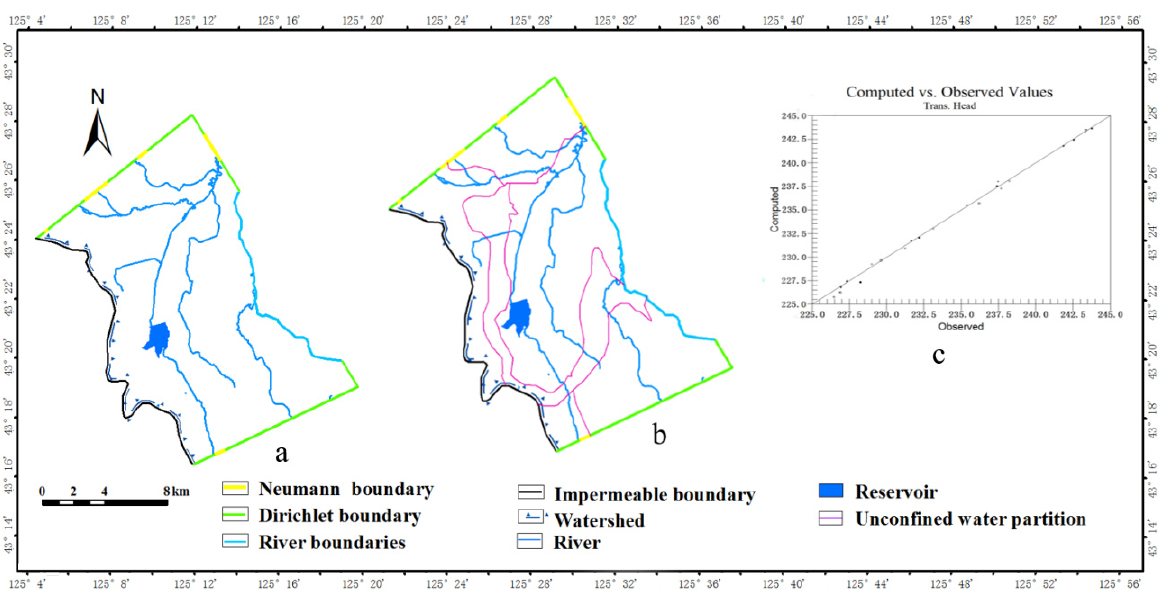
Figure 4. ( a ) Boundary condition mapping of the study area. ( b ) Phreatic water partition mapping. ( c ) Scatter plot of observed and simulated groundwater level based on calibration. Table 4. Calculated value of sources-sinks and the final hydrogeological